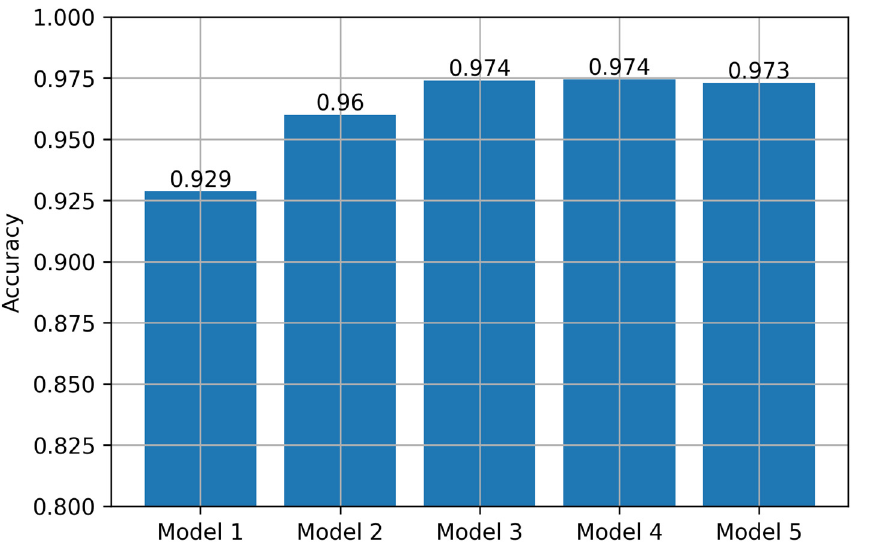
Figure 11. Learning curves of a VGG16 model (Model 3). Data augmentation yielded only a slight improvement in accuracy (Figure 12). How- ever, it contributed to variance reduction, as seen in Figure 13 (results obtained from Model 2). The dropout technique was effective only for Model 5 (96% accuracy), while the rest models were not capable of learning. The models generated similar results for weight regularisation, as presented in Figure 10.